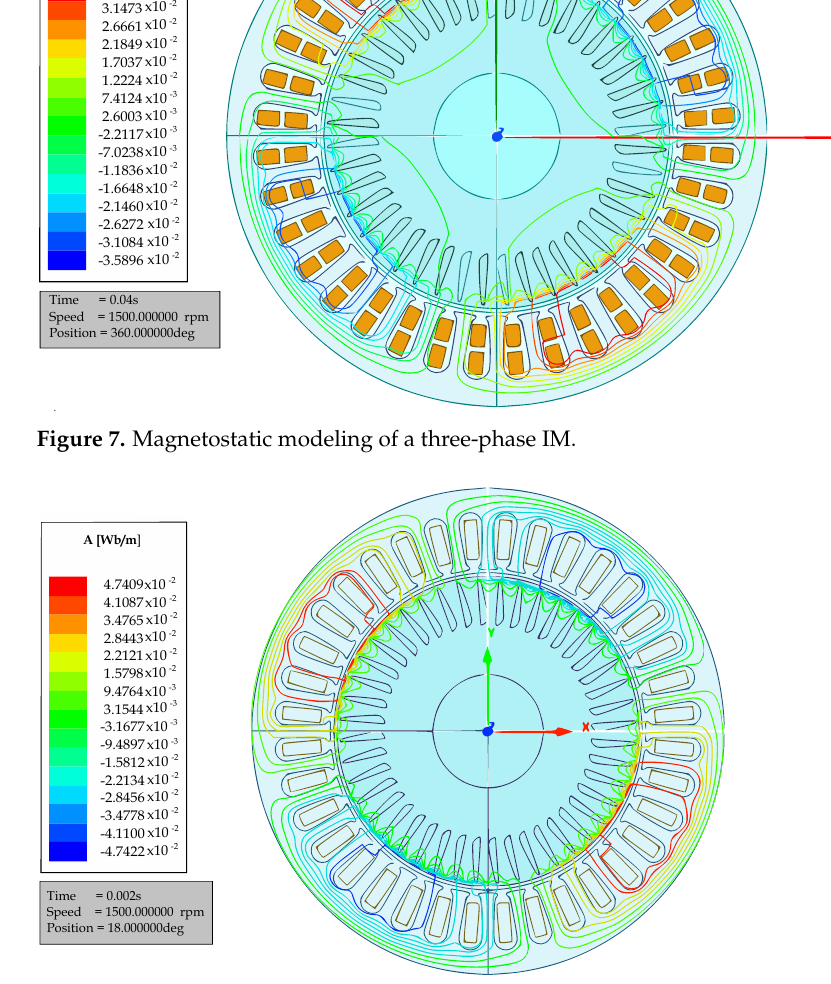
Figure 8. Magnetostatic modeling of a nine-phase